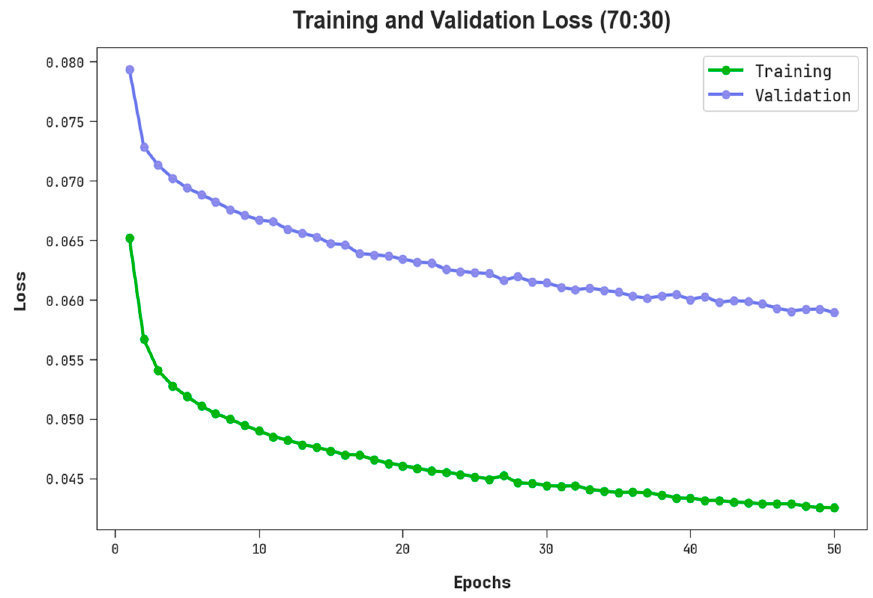
Figure 8. TLS and VLS outcome of RHSODL-AMD system on 70:30 of TRS/TSS. Figure 9 reveals the classifier outcomes of the RHSODL-AMD system under 80:20